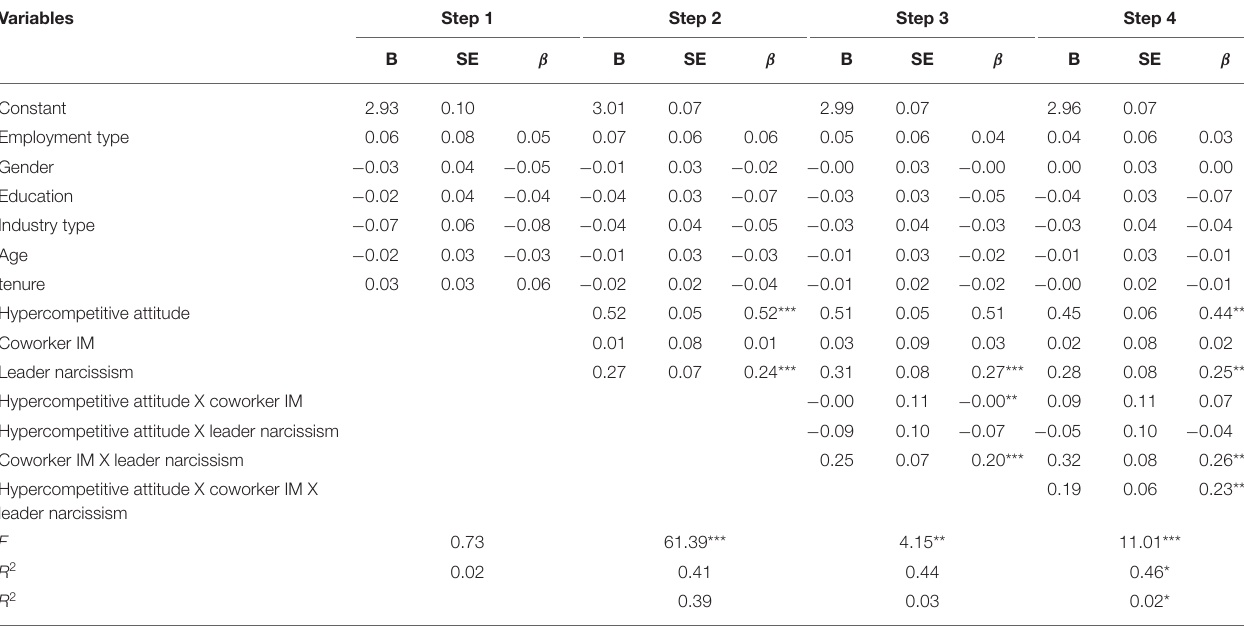
TABLE 4 | Interaction effects of hypercompetitive attitude, coworker IM, and leader narcissism on aggression intention. Variables Step 1 Step 2 Step